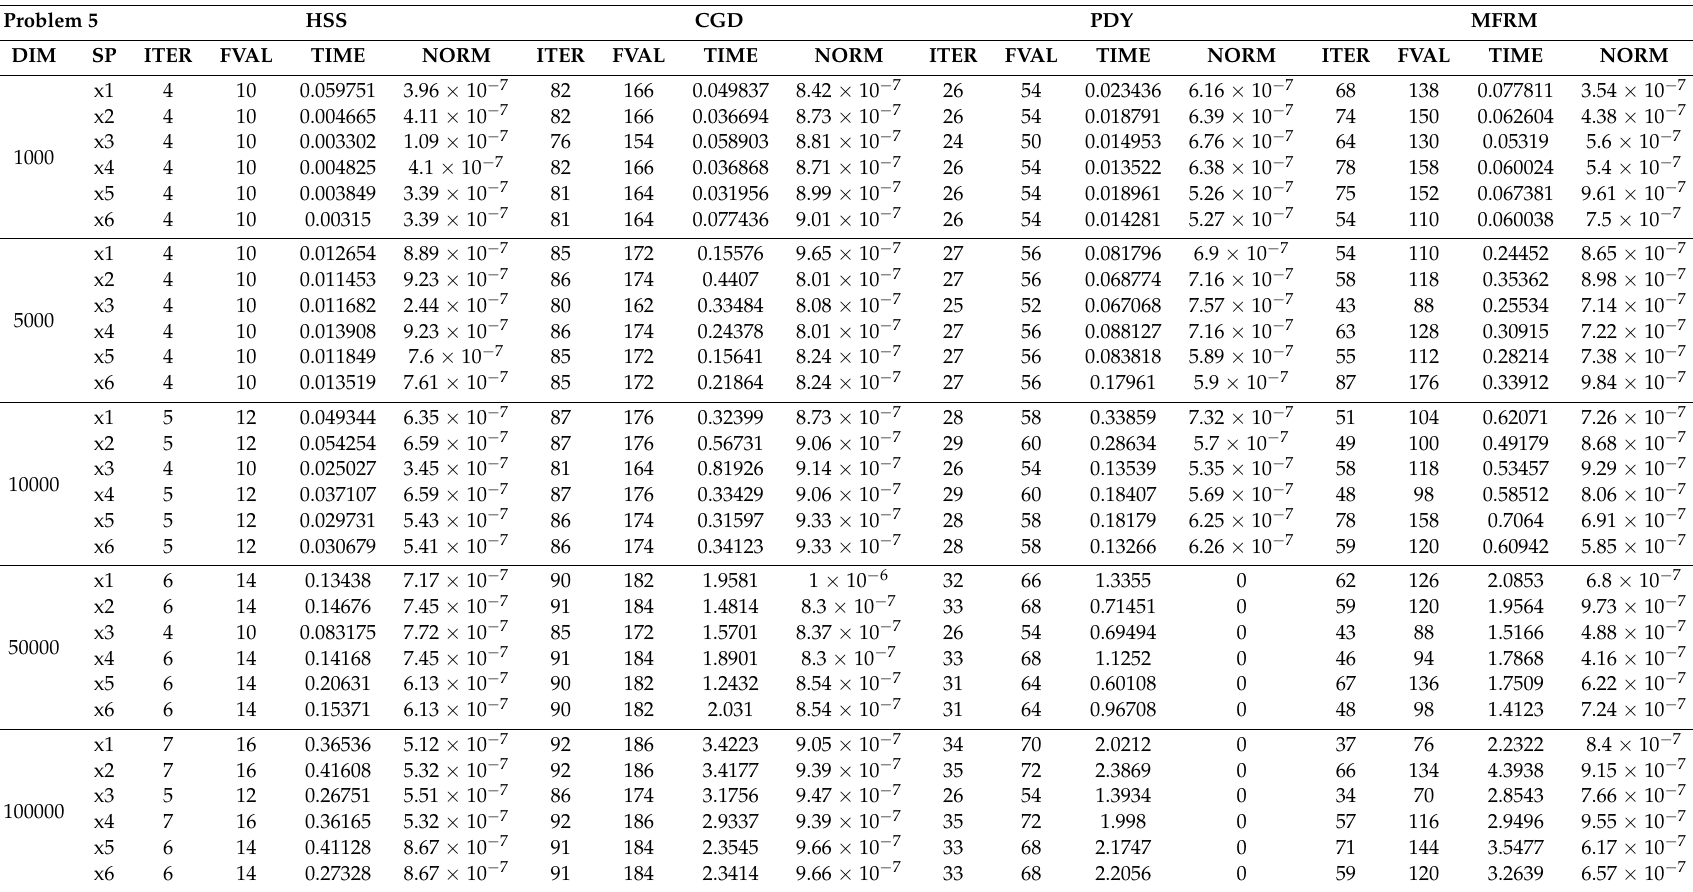
Table 5. Test results obtained by the four solvers for Problem